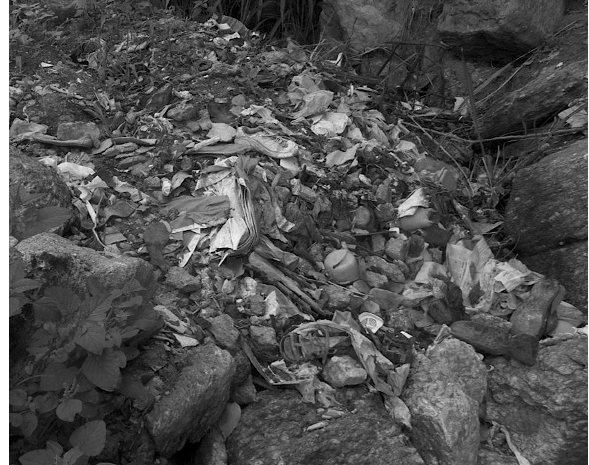
Figure 4. Trash littering the ground in